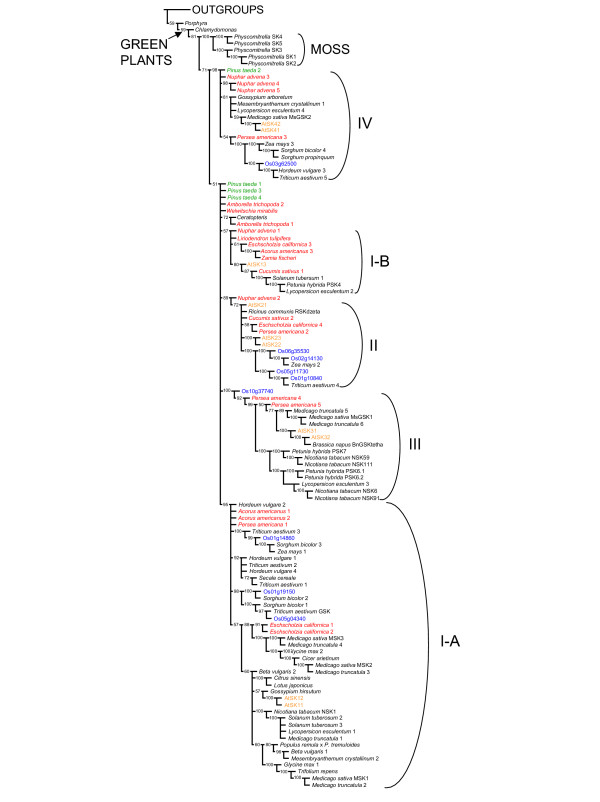
Phylogenetic tree resulting from analysis of nucleotides using Support Weighting with jackknife values from non-weighted analysis. Orange labels indicate GSK homologs from Arabidopsis, and blue labels designate rice sequences. GSK homologs from FGP ESTs are labeled in red. Pinus ESTs are labeled in green.